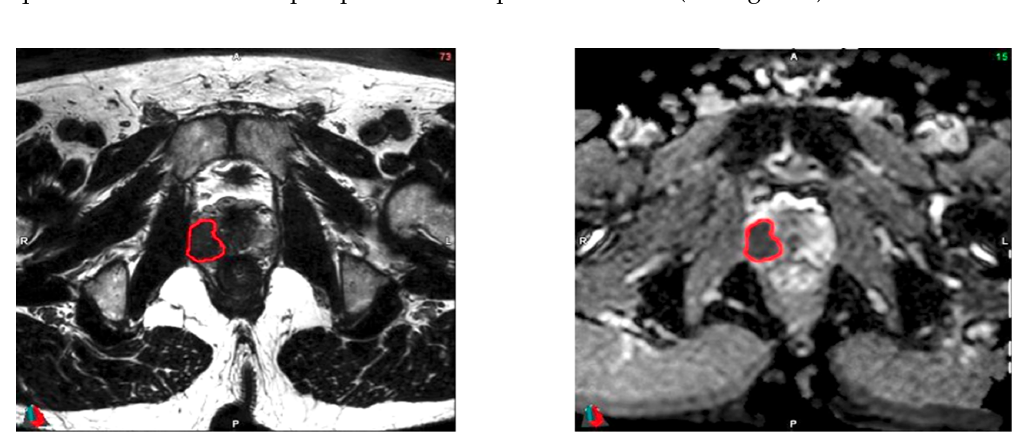
Figure 2. Examples of delineation on both T2 (left) and ADC (right) sequences. Images acquired on a Philips 3T Scan. Patient #27: Initial PSA (Prostate Specific Antigen) of 6.80 ng / mL, no clinical anomaly. MRI: suspicion of extracapsular extension. Pathology exam: Gleason score of 9 (4 + 5), bilateral invasion of the prostate (pT2c). Magnification scale: ×